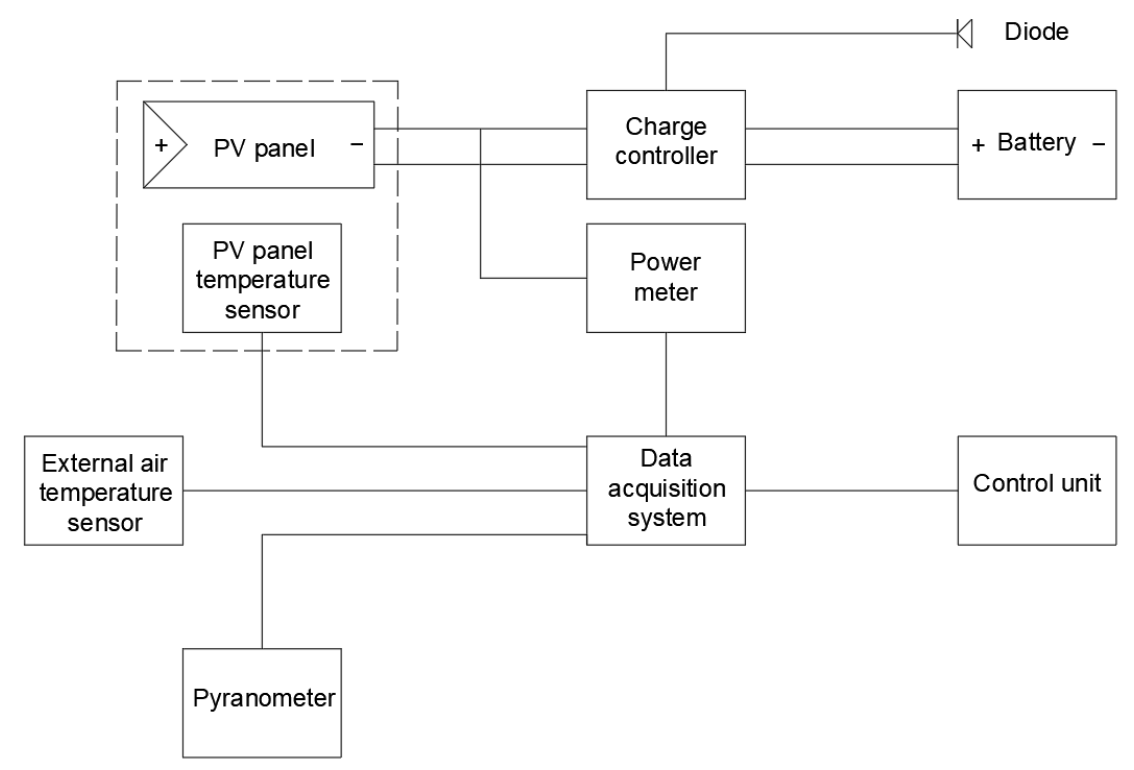
Figure 4. Scheme of the experimental setup.